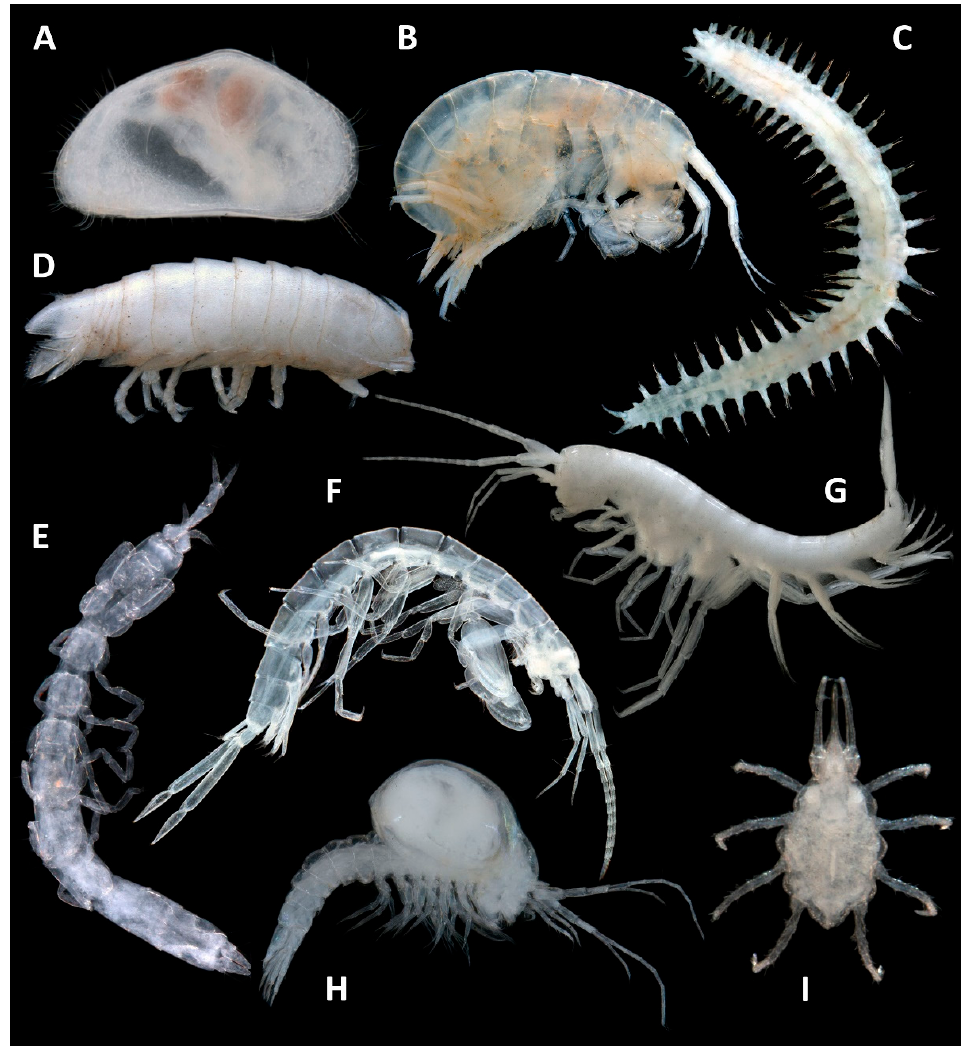
Figure 5. Stygofauna at Robe 2A and 1A. ( A ) Humphreyscandona fovea ; ( B ) Wesniphargus ‘Helix- AMN004’; ( C ) Namanereis pilbarensis ; ( D ) Kagalana tonde ; ( E ) Microcerberidae sp.; ( F ) Eriopisidae gen. nov. ‘Helix AMM006’; ( G ) Nedsia ‘mcraei’ King & Cooper in press; ( H ) Halosbaena sp. PL.; ( I ) Peza sp. Photos by Jane McRae.